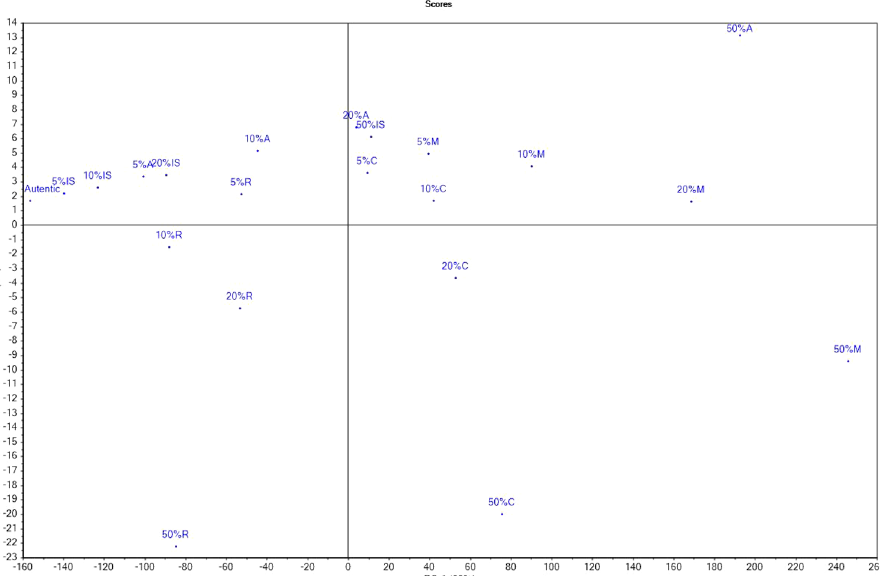
Figure 5. Principal component scores of honey and honey adulterated: IS inverted syrup, C corn syrup, M maple syrup, A agave syrup, R rice